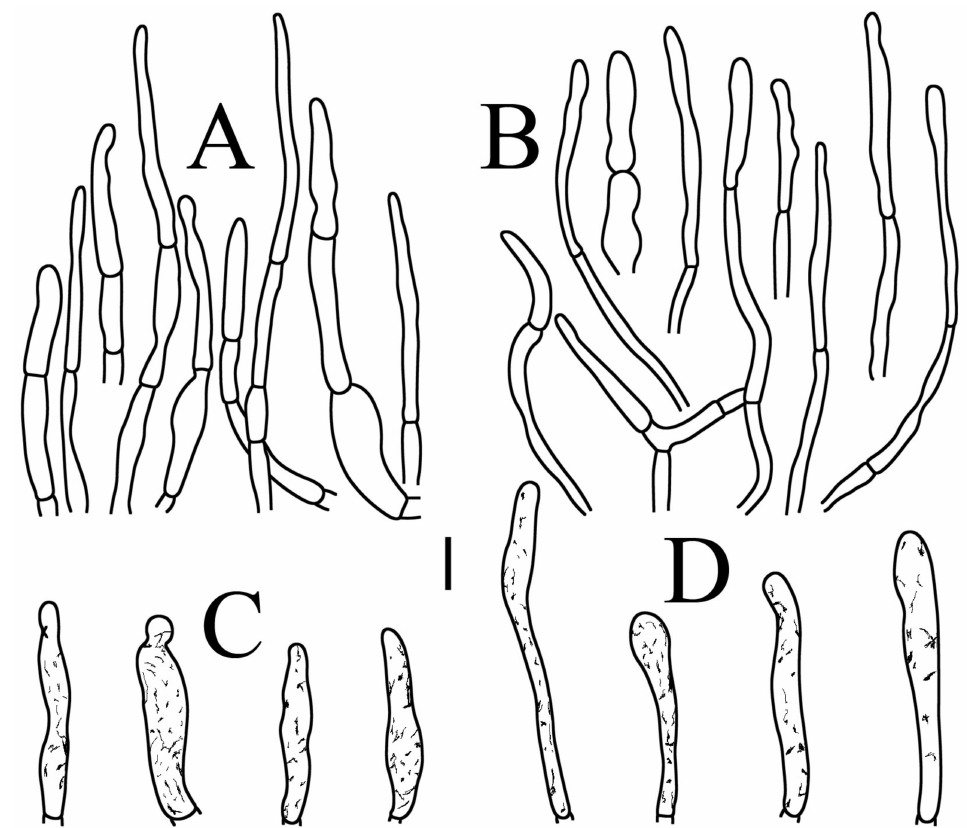
Figure 5. Russula brevispora. (HGASMF-009915, holotype): ( A ) hyphal terminations near the pileus margin; ( B ) hyphal terminations near the pileus center; ( C ) pileocystidia near the pileus margin; ( D ) pileocystidia near the pileus center. Scale bars: 10 µ